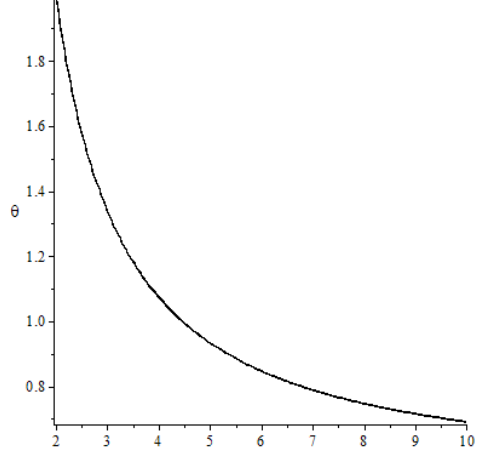
Figure 1. Price of land measured in terms of capital and number of firms.